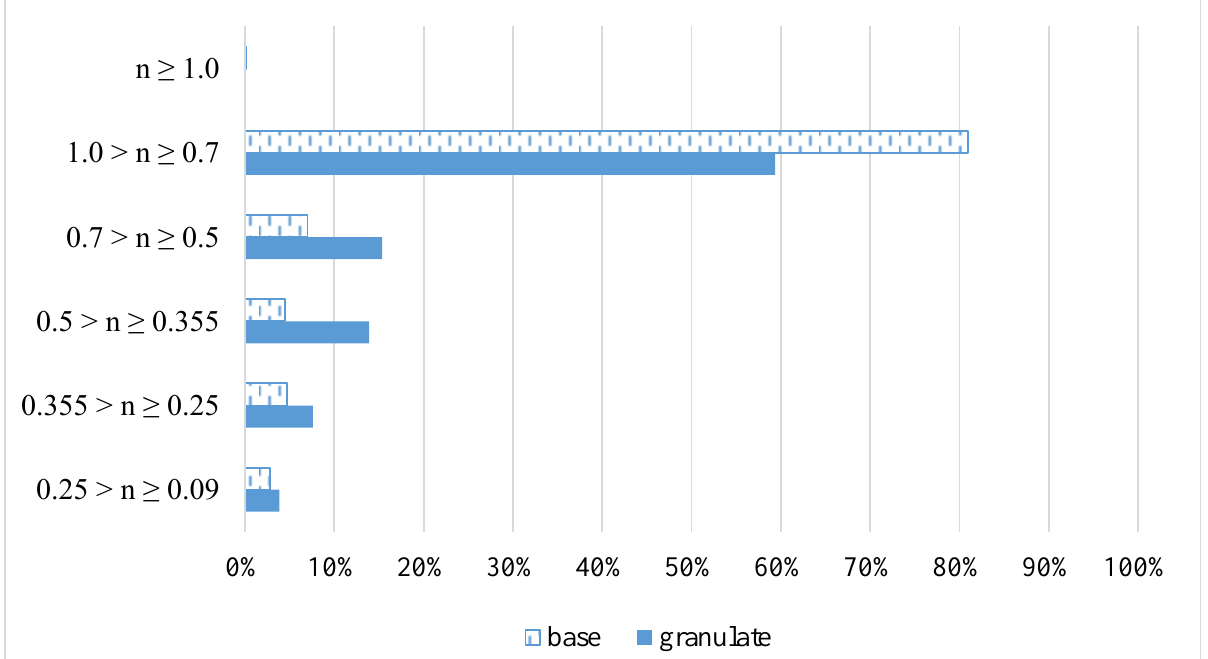
Fig. 2. The fractional composition of the granulate and the composition HiG PWD-01